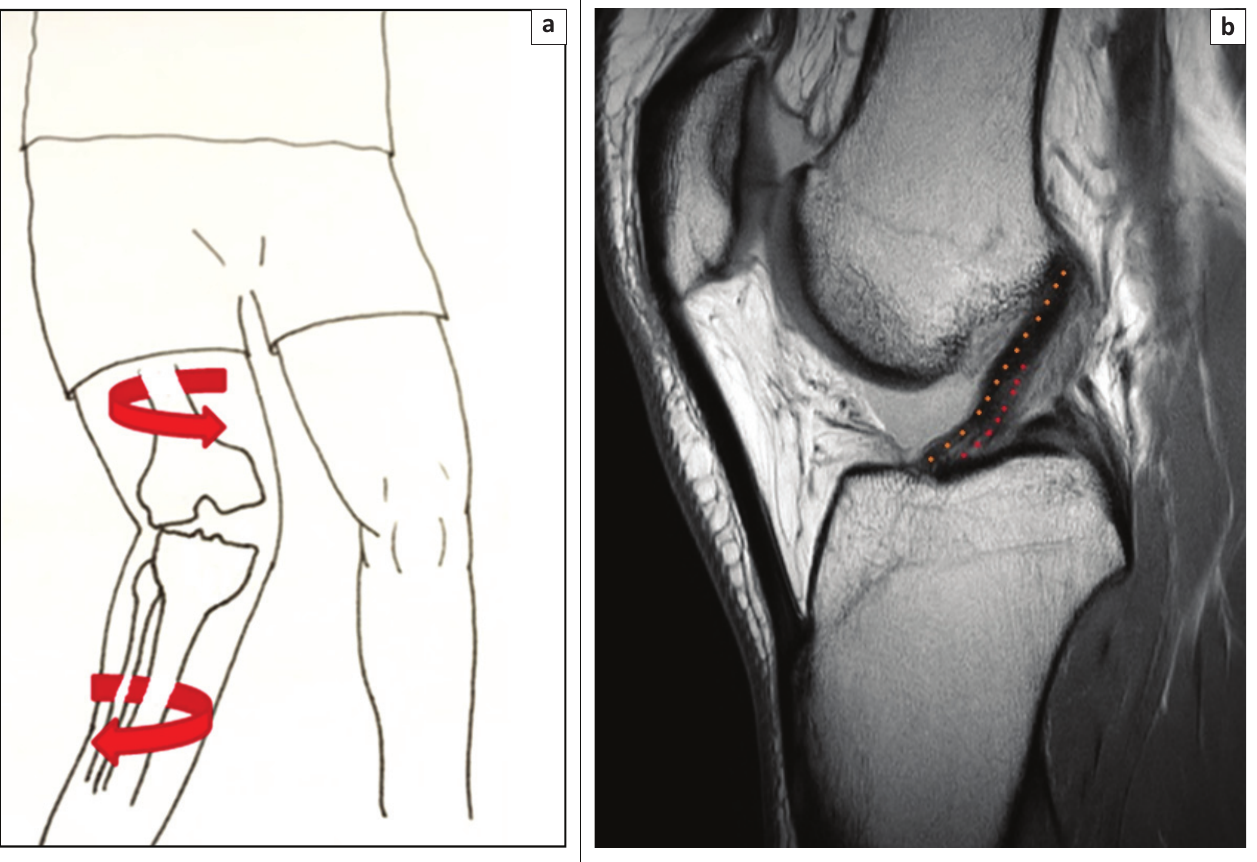
FIGURE 6: Flexion, valgus and external rotation: (a) Schematic depicts excessive sudden internal rotation of femur on ‘fixed’ tibia (effective external tibial pivot) with knee in flexed valgus position, (b) anterior cruciate ligament (ACL) tear that results from excessive rotation, (c) non-contiguous impactions at the lateral femoral condyle and posterolateral tibia that occur once the ACL has given way and (d) right knee medial collateral ligament (MCL) tear which is often incomplete; look for avulsion bone bruise at deep (purple) and superficial (green) MCL portion